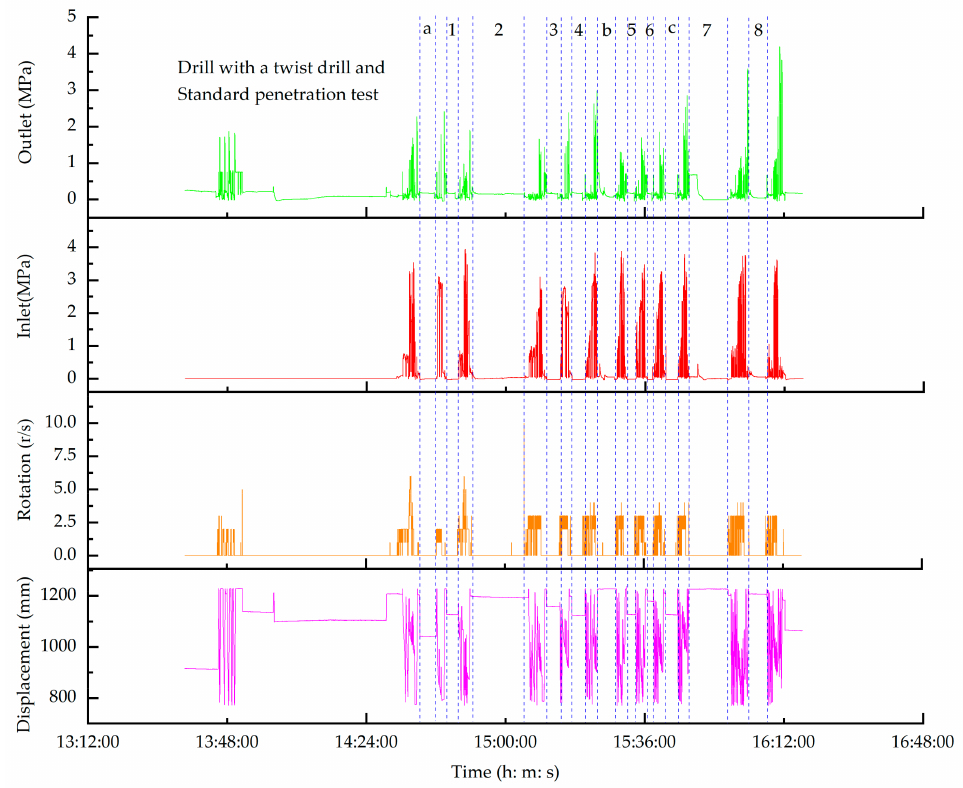
Figure 5. Rock-breaking response information–drilling time curves of a drilling rig drilling in Yan’an city on 8 September 2018 (drilling depth: 0.00–10.20 m. Outlet means oil pressure of outlet pipe, Inlet means oil pressure of inlet pipe, Rotation means drill rod rotation speed, Displacement means drill bit displacement, same as